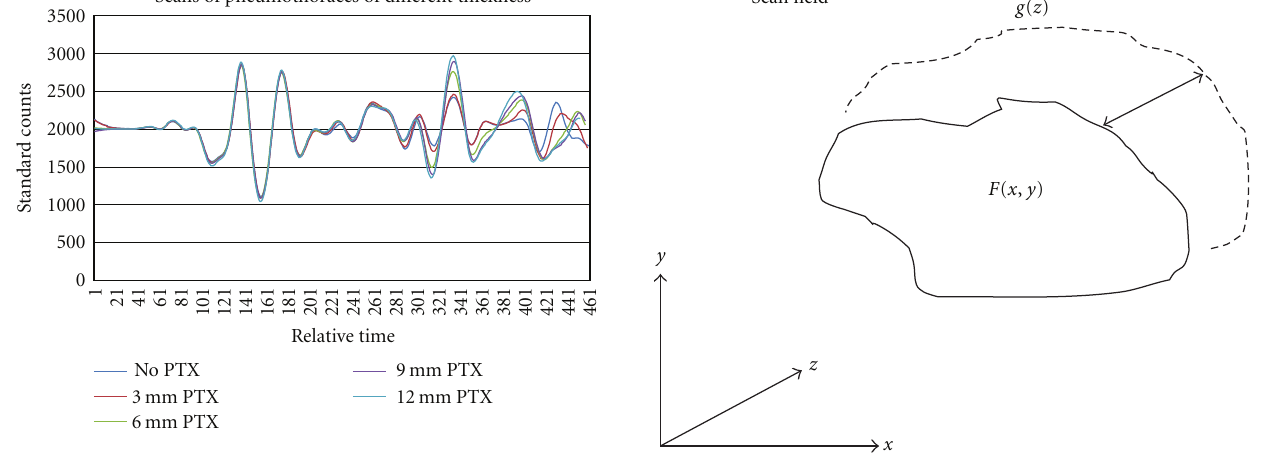
Figure 8: Microimpulse radar scan field and volumetric